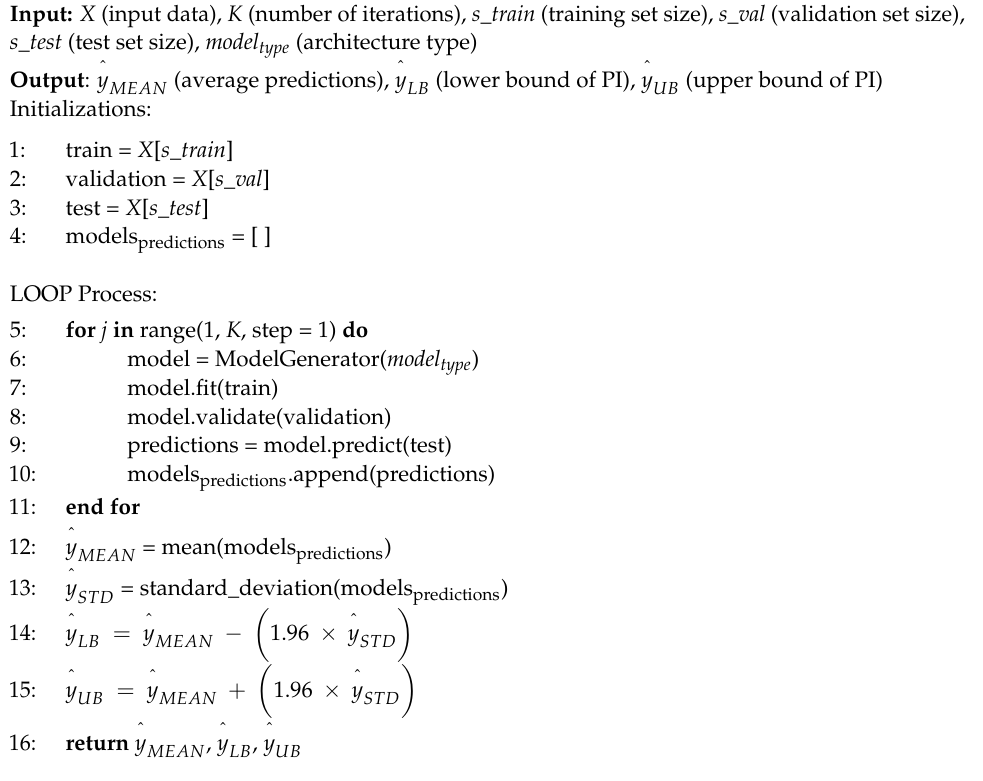
Algorithm 2 95% Prediction Interval (PI) estimation